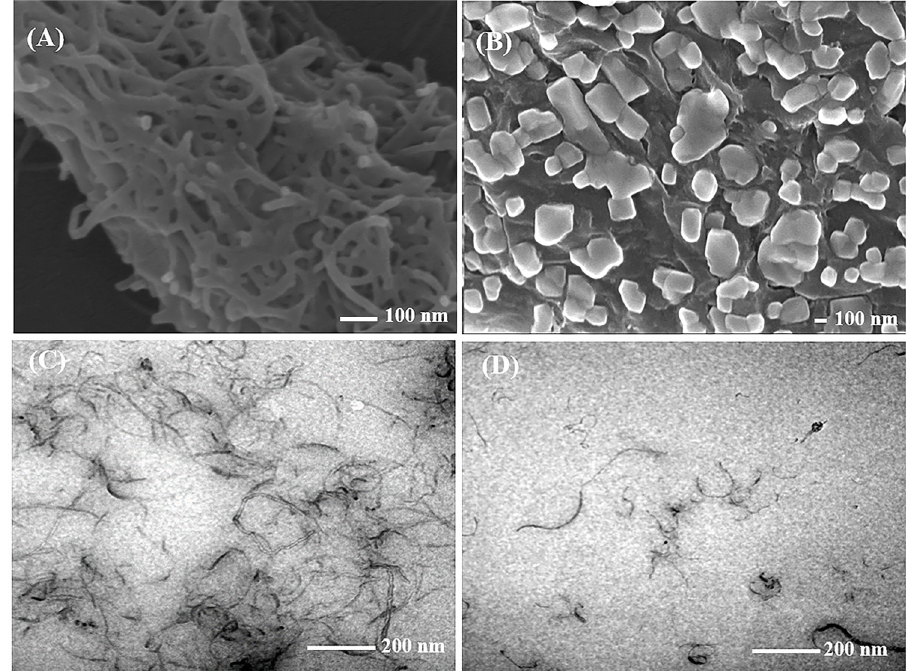
Figure 1. fMWCNTs and fMWCNTs-mPEG were characterized by scanning electron microscopy (SEM) and transmission electron microscopy (TEM). ( A ) SEM images of fMWCNTs, ( B ) SEM images of fMWCNTs-mPEG; ( C ) TEM images of fMWCNTs and ( D ) TEM images of fMWCNTs-mPEG. The materials were diluted 100 times according to the proportion of electrode modification; SEM and TEM magnification of 100,000 × .